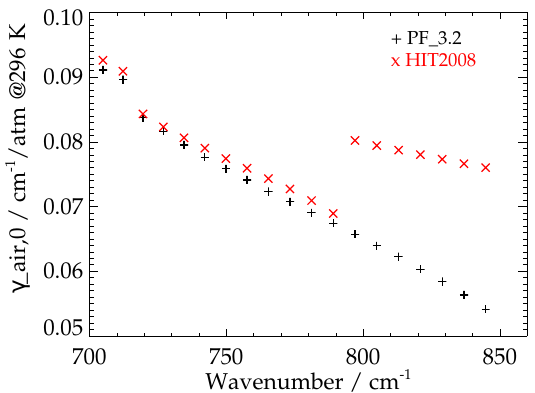
Figure 13. Air-broadened half widths γ air , 0 of several ozone lines of the fundamental ν 2 ozone band in the MIPAS-pf3.2 (black) and HITRAN-2008 spectroscopy